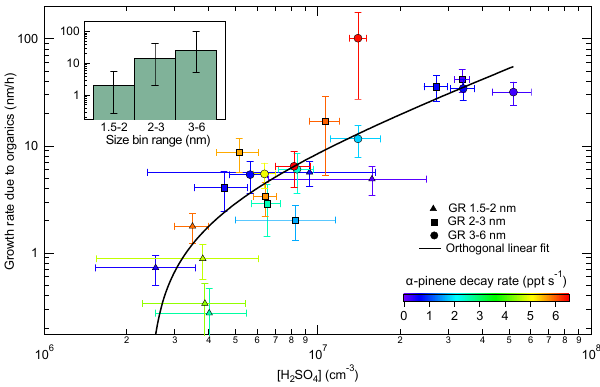
Fig. 7. Initial growth rates attributable to organic compounds ob- served with the CPC battery as a function of sulfuric acid concen- tration color coded with α -pinene decay rate (different markers cor- respond to different size ranges). The error bars represent the stan- dard deviations. Large error bars on the sulfuric acid concentrations in the 1.5–2nm size range are caused by the fact that [H 2 SO 4 ] had not reached its plateau value at the early stage of the experiment when these GR values had been determined. The inset shows the average growth rates attributable to organics as a function of the particle diameter, the bars indicate the minimum and the maximum GR in each size